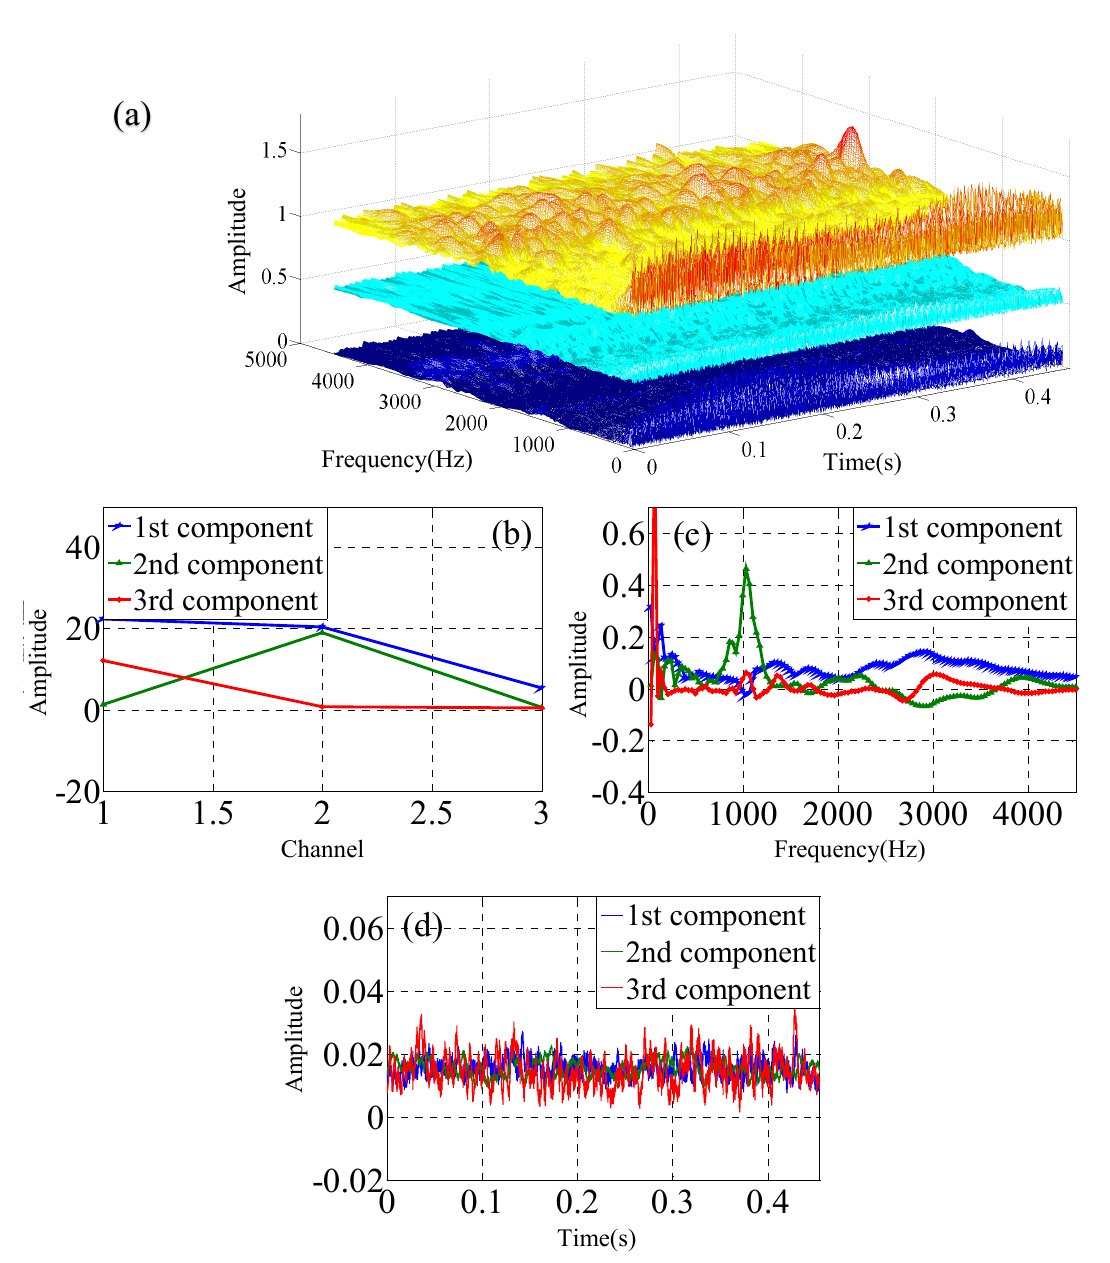
Figure 4. PARAFAC for one data from one channel of single sensor under F1 condition, ( a ) CWT of single-channel data, ( b ) mode 1, ( c ) mode 2, ( d ) mode 3.